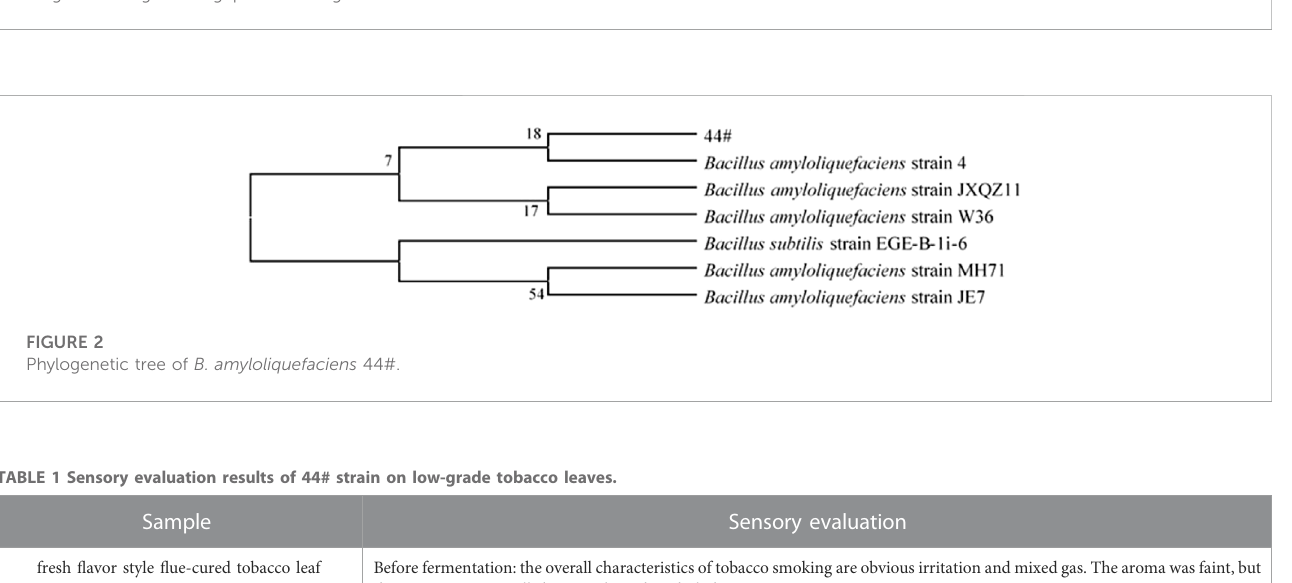
FIGURE 1 Diagram for high-throughput screening of functional strains.